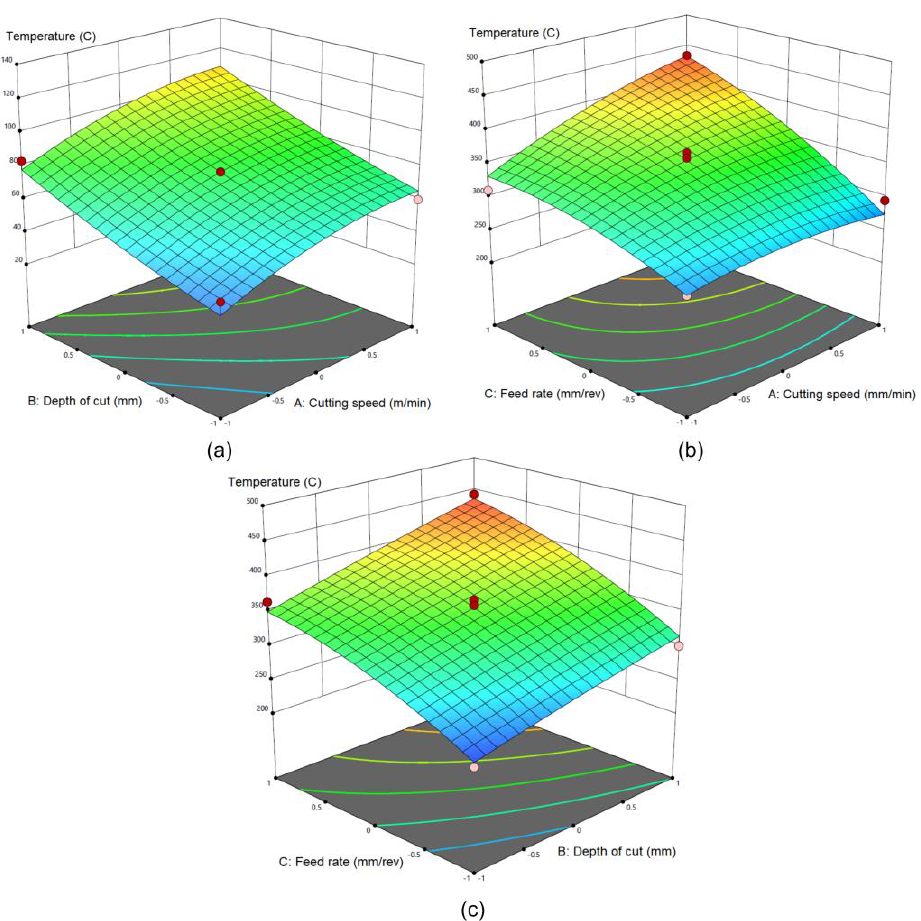
Figure 7. The effects of the parameters affecting the turning of the AISI 52100 bearing steel material on the temperature variable: ( a ) depth of cut-cutting speed; ( b ) feed rate-cutting speed; ( c ) feed rate-depth of cut.